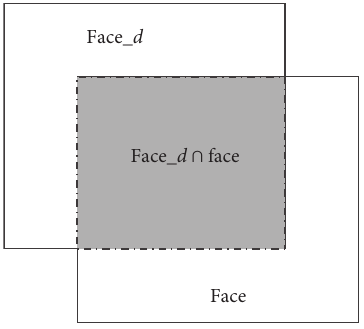
Figure 14: Intersection over